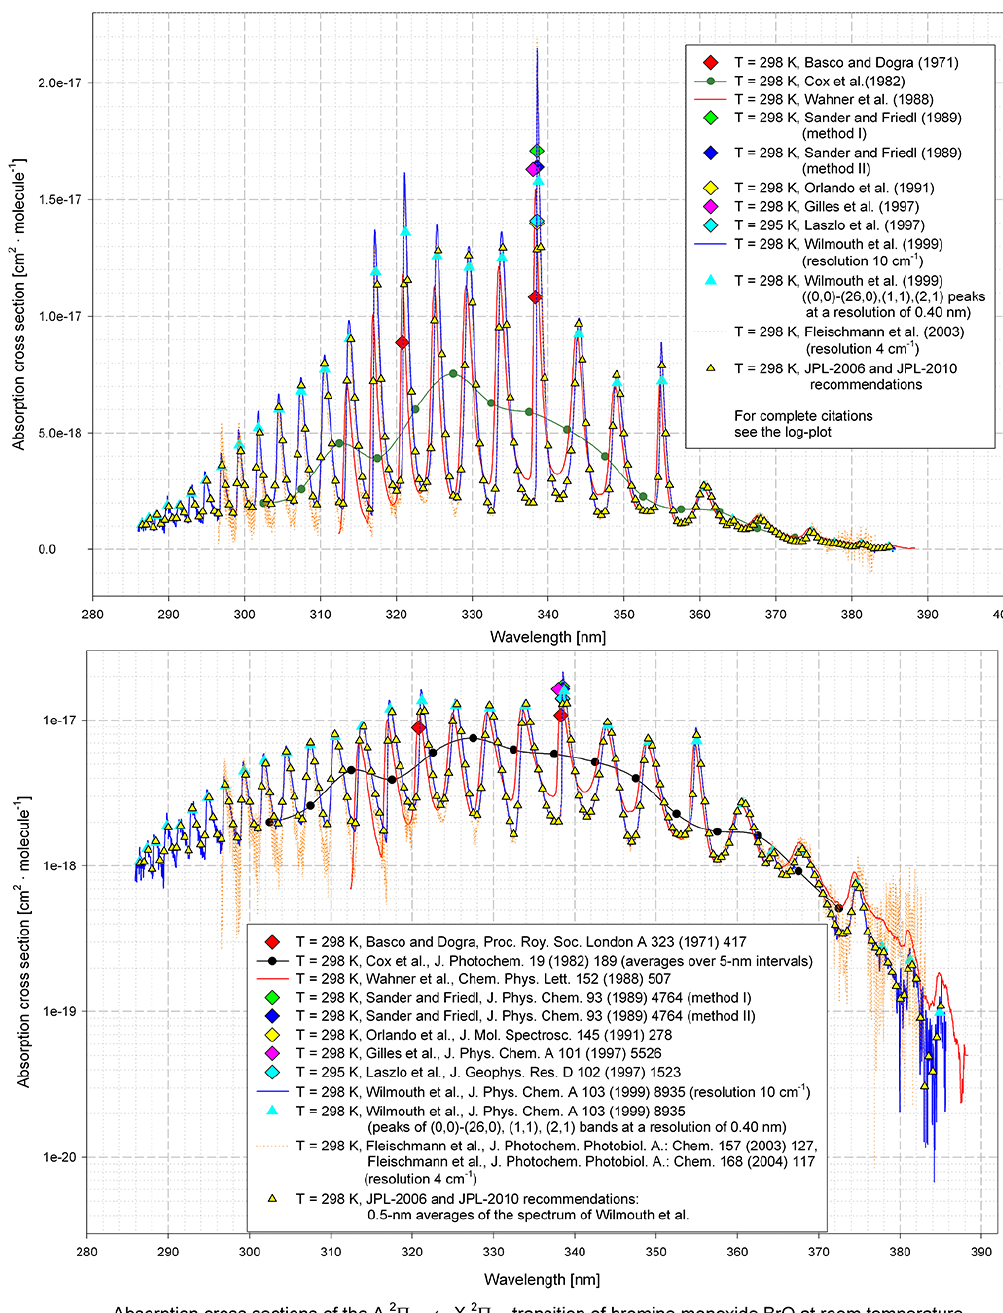
Figure 1. Overview plots of measured BrO spectra (top = linear, bottom = logarithmic).